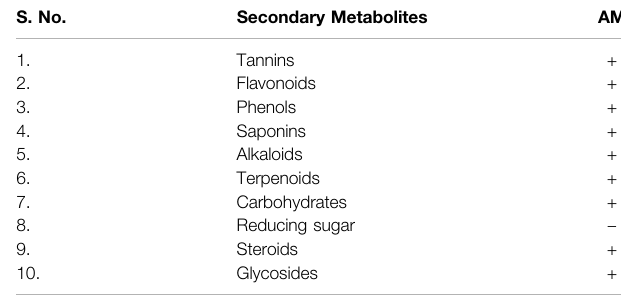
TABLE 1 | Composition of ethosomes formulations. Formulation code